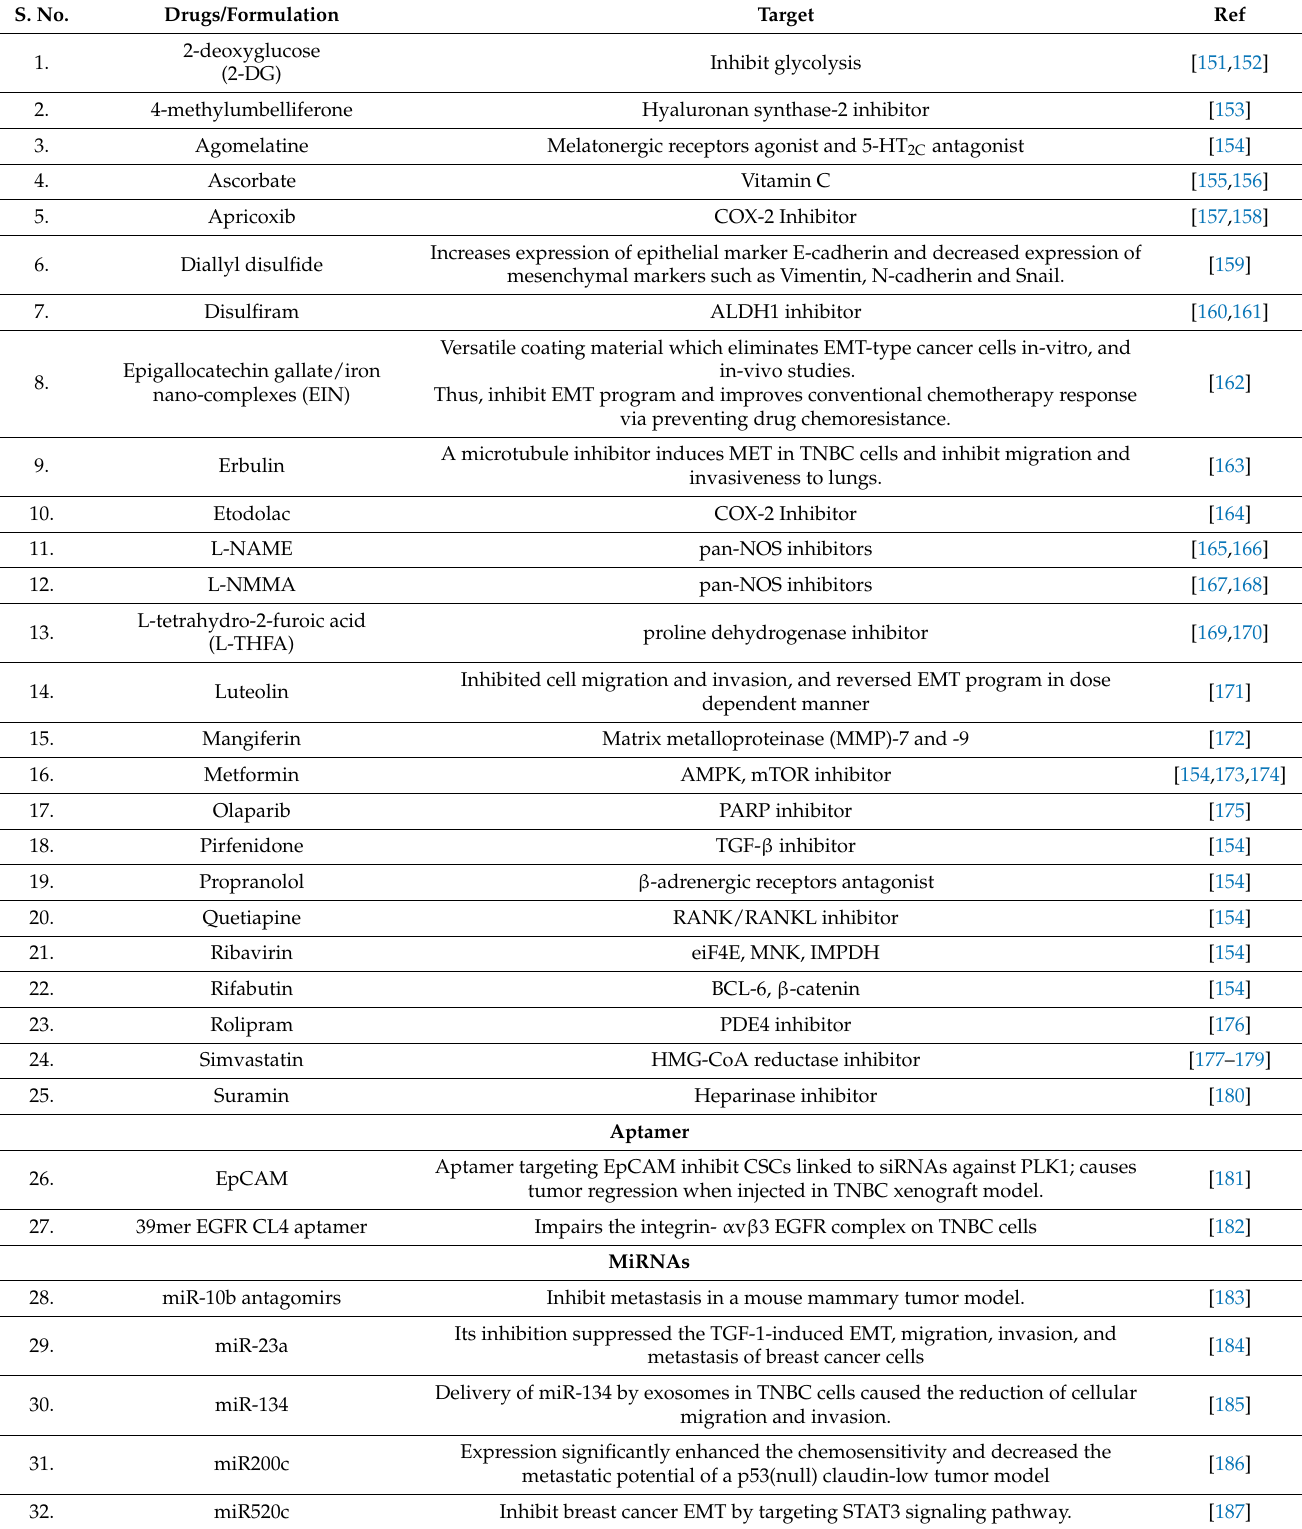
Table 4. Exogenous Blockers of EMT program in breast